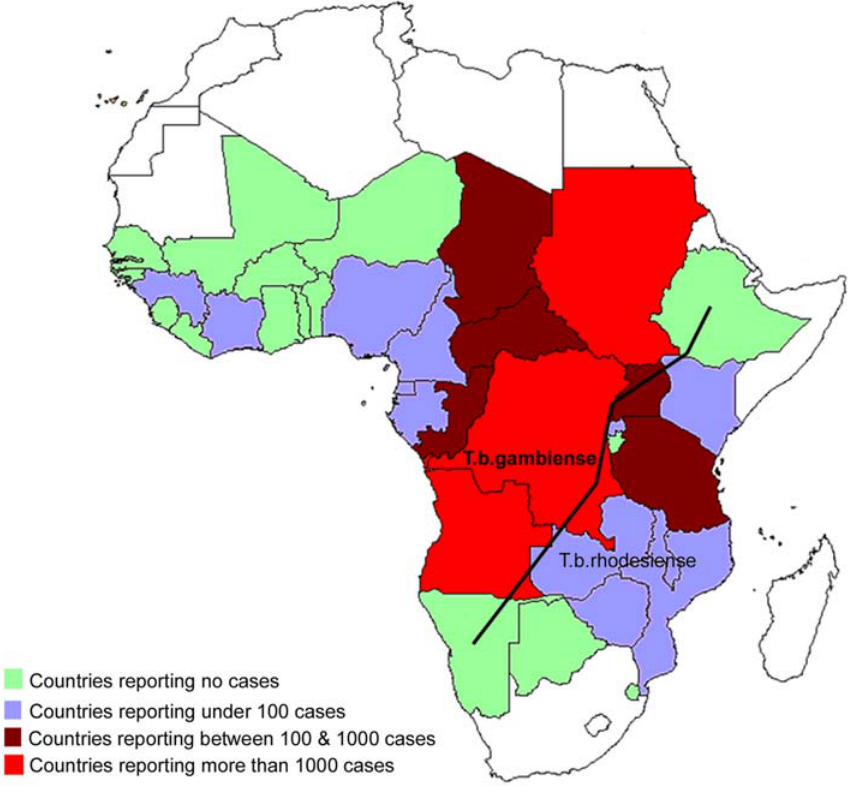
Figure 1. Map of Sleeping Sickness. Image credit: [23].